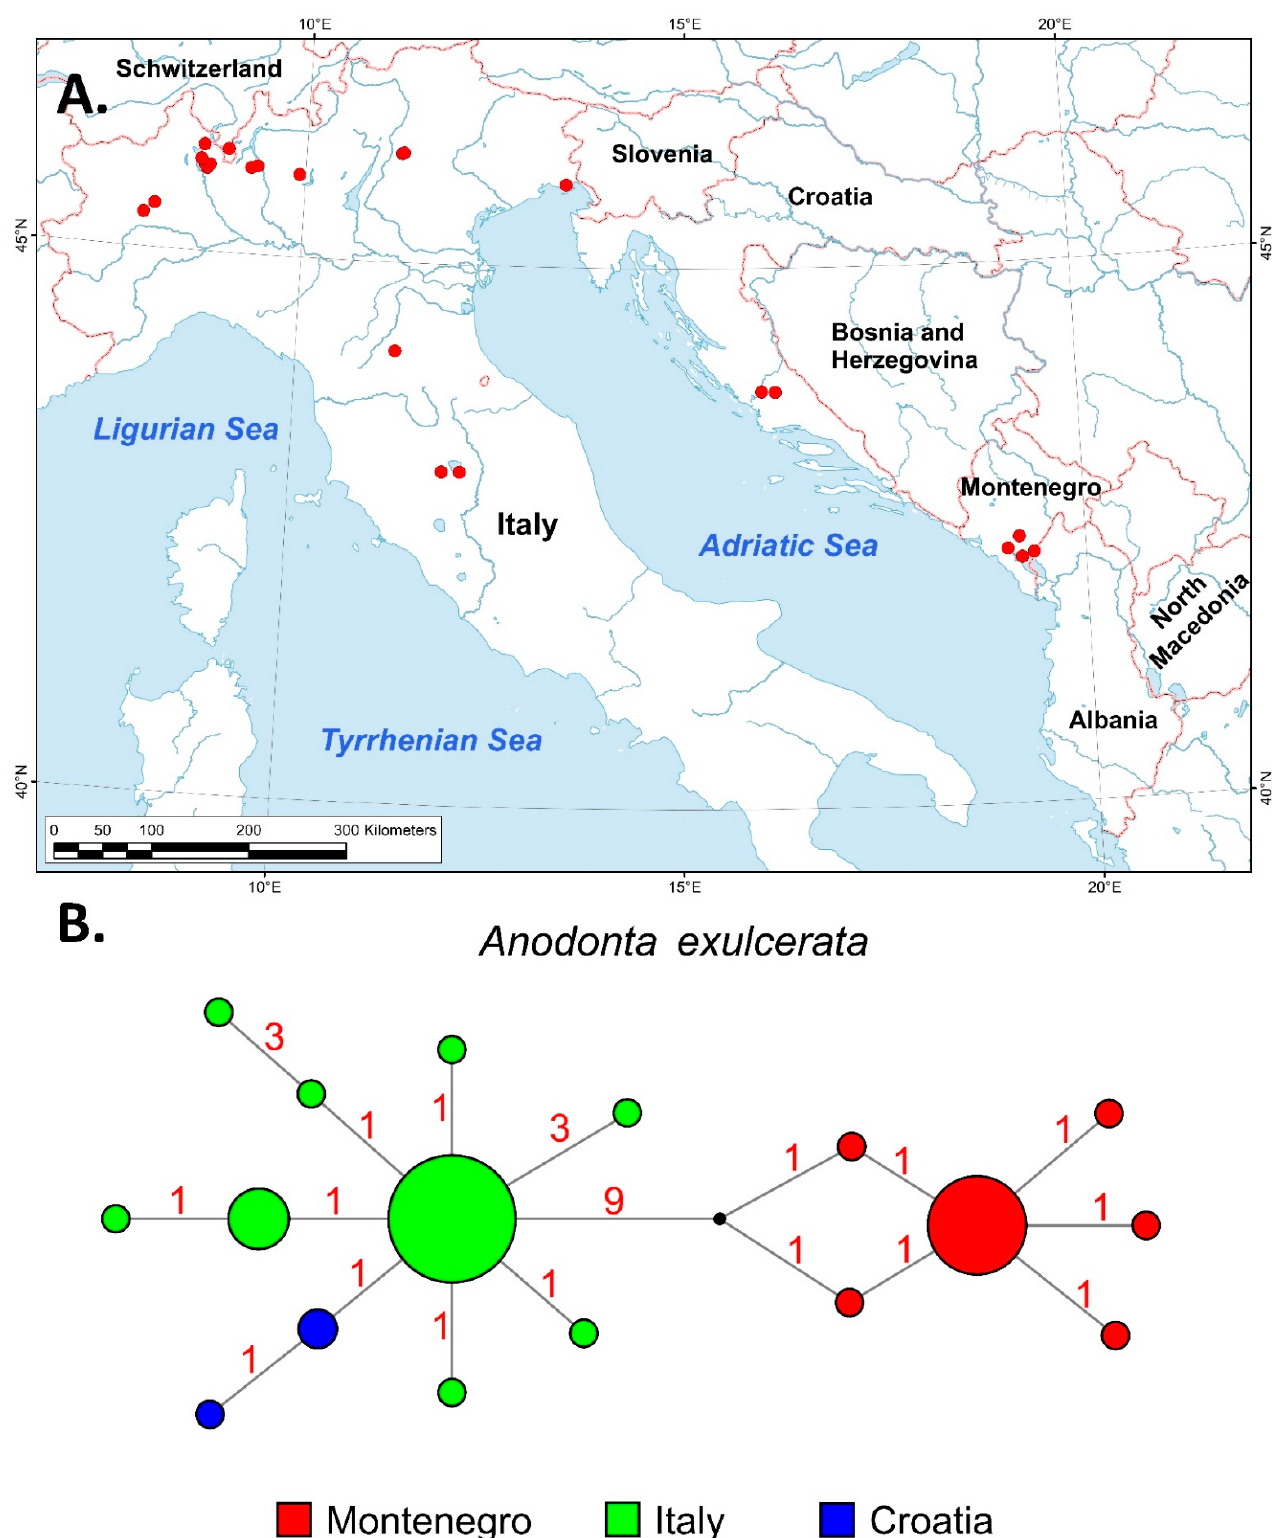
Figure 4. Distribution and phylogeography of Anodonta exulcerata : range map ( A ) and median-joining network ( B ).